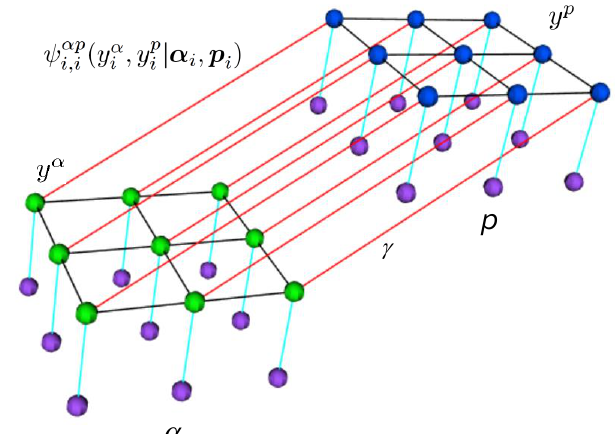
Figure 2. Graph representation of CRFL. The purple nodes denote random variables associated with the observed data, the green nodes denote random variables associated with the labels y α , blue nodes denote random variables associated with the labels y p . The turqoise lines denote the link of the labels with the observed data. Black lines denote the edges that model the spatial neighborhood dependencies. Red lines denote the cross links between ( α , y α ) and ( p , y p ) encoding the